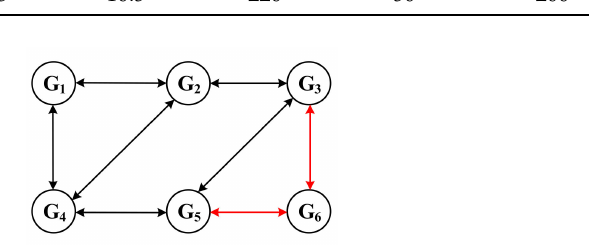
Figure 3. Topology of the communication network.